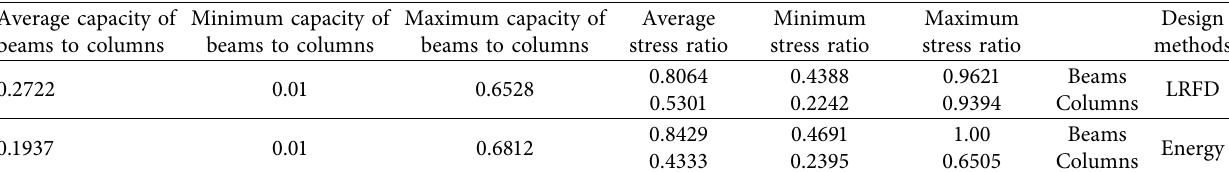
Table 8: Results of the analyses of LRDF, energy, and E-WOA methods in 24-story